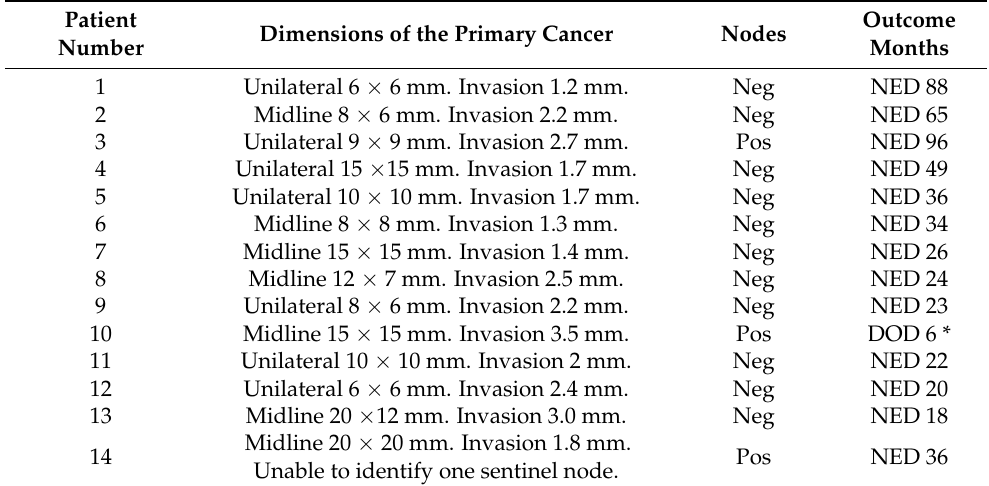
Table 1. Patients with a squamous cell carcinoma of the vulva that was 20 mm or less in diameter with >1 mm stromal invasion, who had ipsilateral or bilateral ultrasonic surveillance rather than sentinel node biopsy.